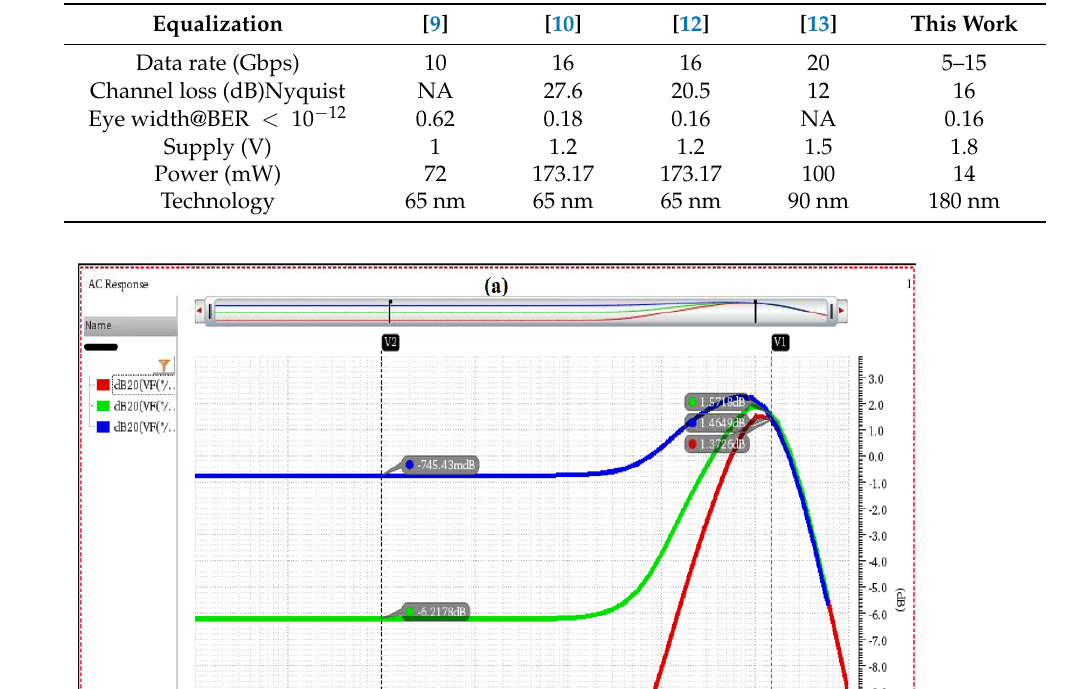
Table 1. Performance comparison.